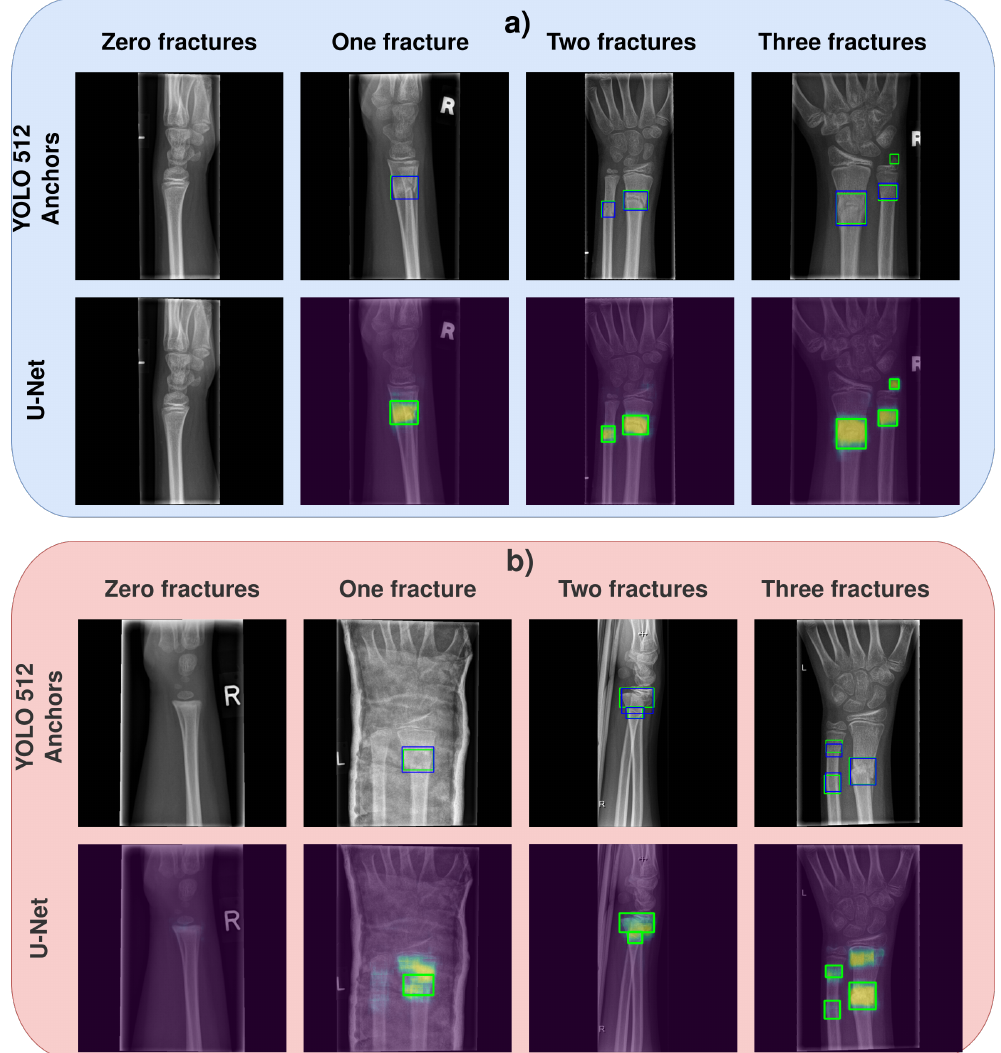
Figure 6. An illustration of the results of fracture detection by the YOLO 512 Anchors model and the U-Net model. The correct fractures are depicted as green bounding boxes, YOLO 512 Anchors output is shown as blue bounding boxes, whereas U-Net output is coloured as viridis type heat map. ( a ) Correctly labelled images containing zero, one, two, or three fractures. ( b ) The shortcomings of the heat maps, which are the final output of the U-Net model (it also depicts YOLO 512 Anchors output as a reference to compare